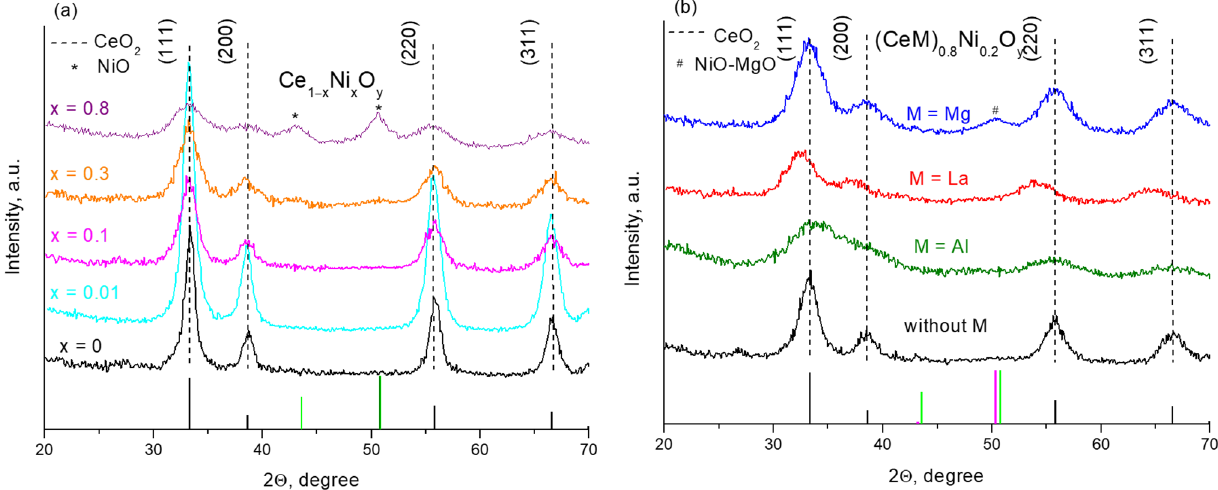
Figure 5. SEM images of (CeM) 0.8 Ni 0.2 O y samples without M ( a ), M = Al ( b ), La ( c ), and Mg ( d ). ( b – d )—M/Ce molar ratio is equal to 1. ( b – d ) M/Ce molar ratio is equal to 1.